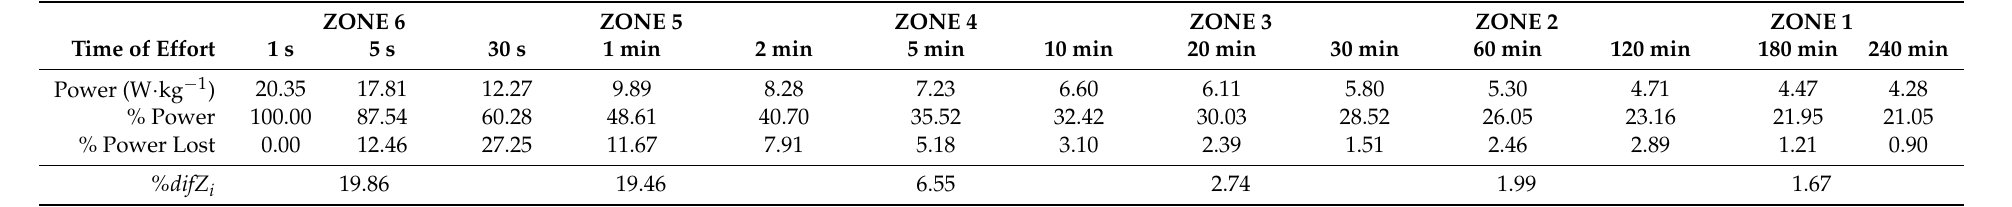
Table 1. Mean power outputs for different exercise durations, showing the power intensity zones and the calculation of the differential factor of each zone with respect to the previous one. Average data from 67 WorldTour cyclists.